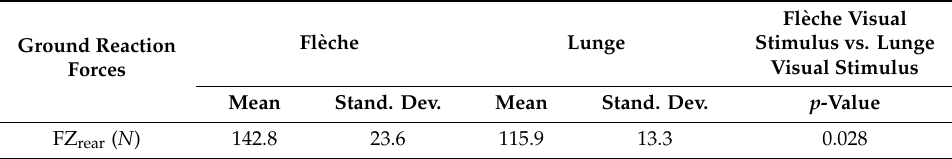
Table 3. Comparison of the mean values of the standard deviation of the ground reaction forces during attacks executed by the fl è che and the lunge.